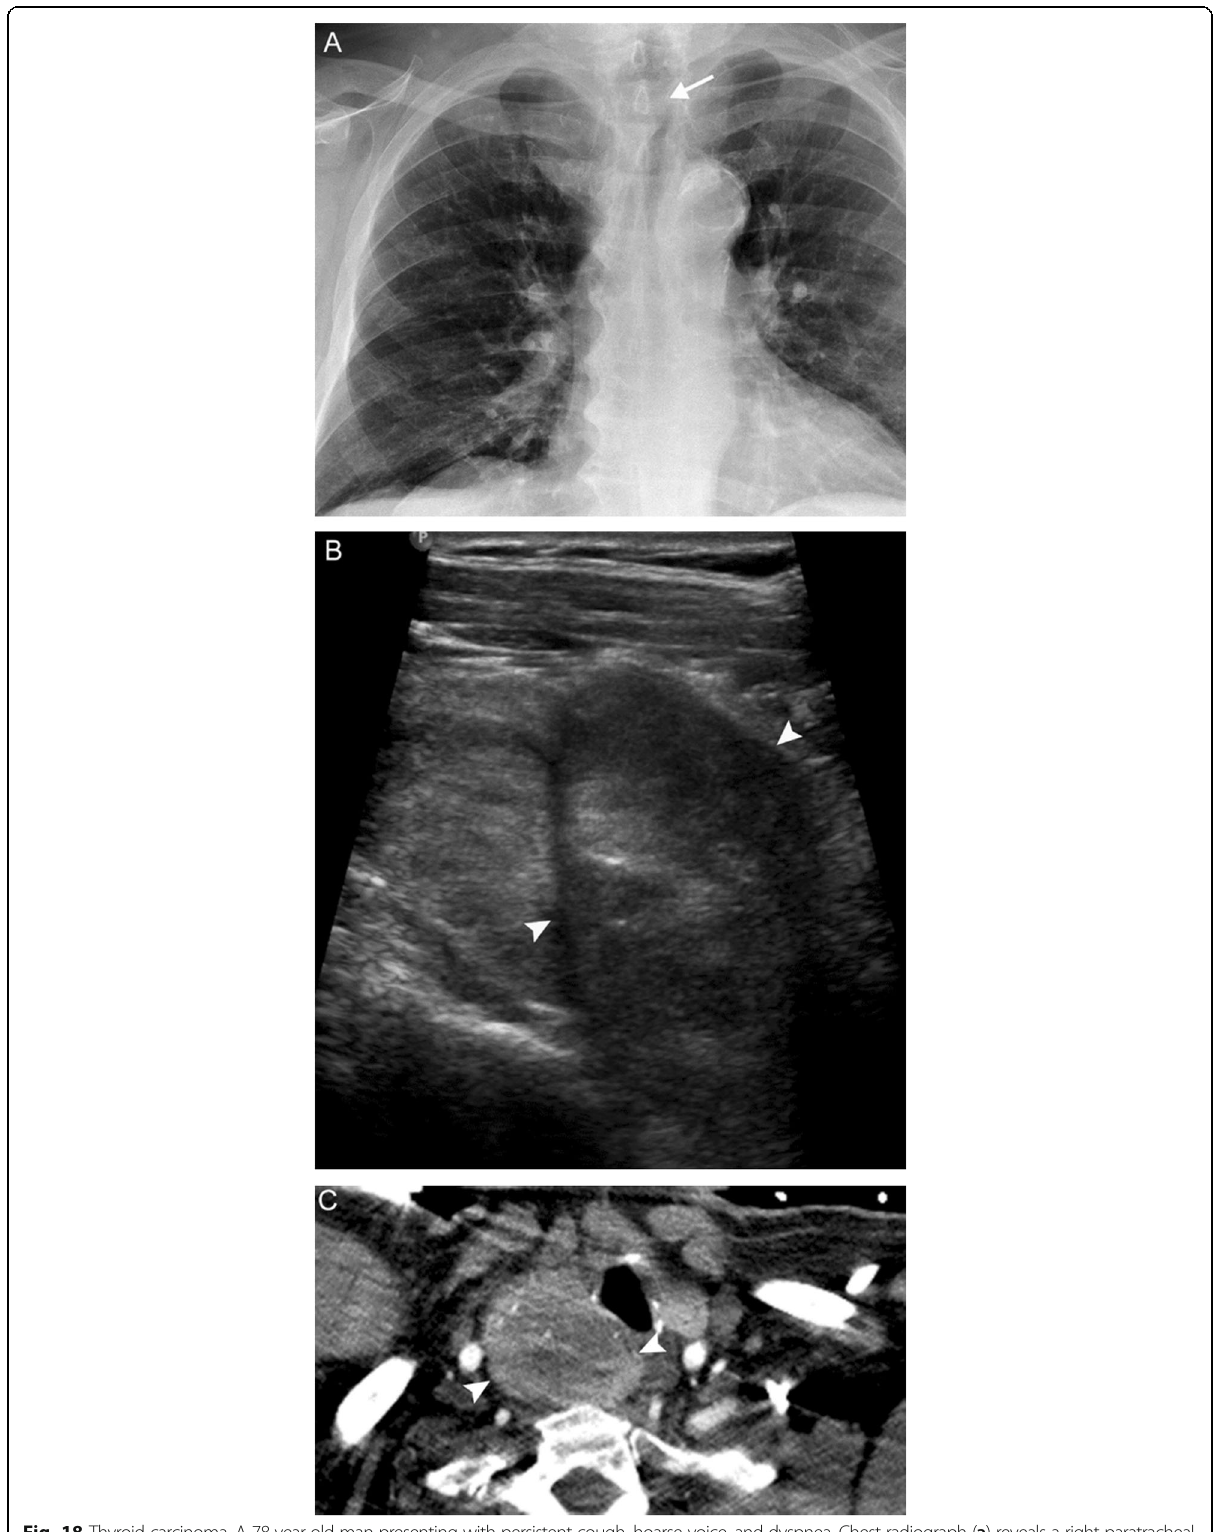
Fig. 18 Thyroid carcinoma. A 78-year-old man presenting with persistent cough, hoarse voice, and dyspnea. Chest radiograph ( a ) reveals a right paratracheal mass indenting the subglottic trachea (white arrow). Subsequent neck US ( b ) and chest CTA ( c ) reveal a solid heterogenous mass with calcifications (white arrowheads), which narrows but does not invade the glottic/subglottic airway. Fine needle aspiration revealed follicular thyroid